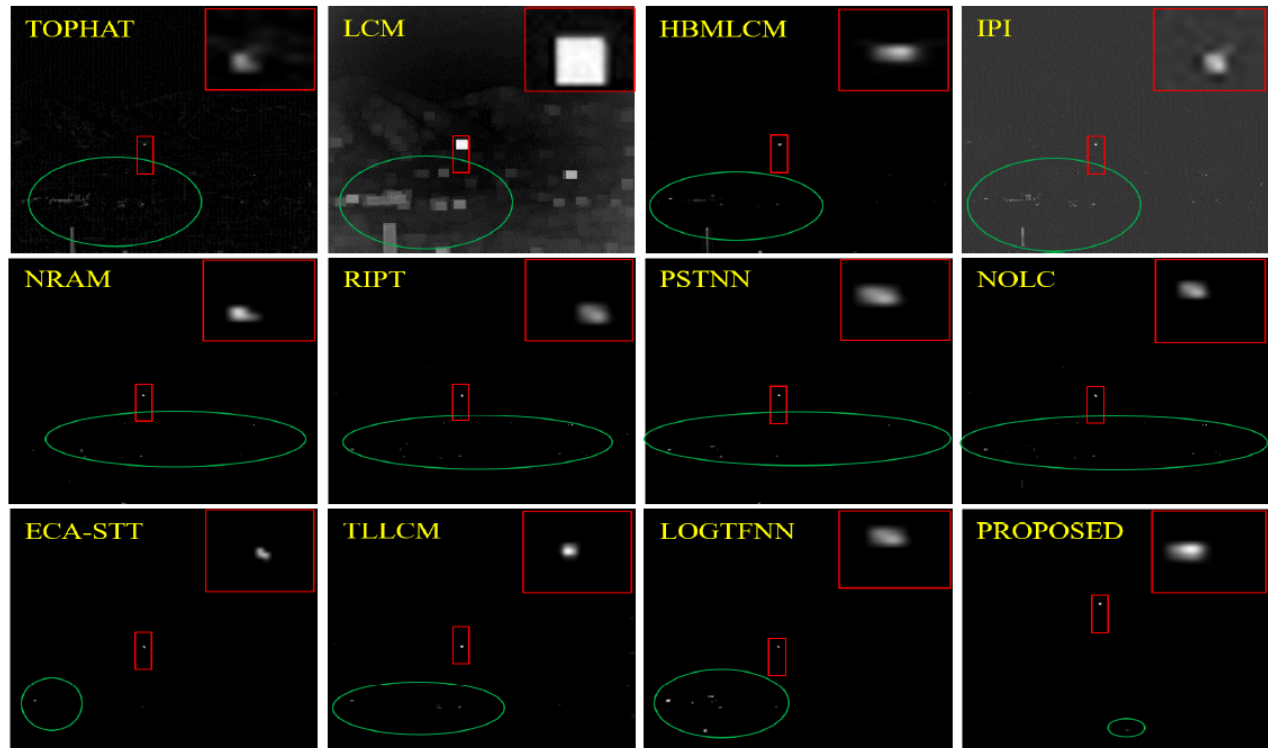
Figure 26. The detection results of data